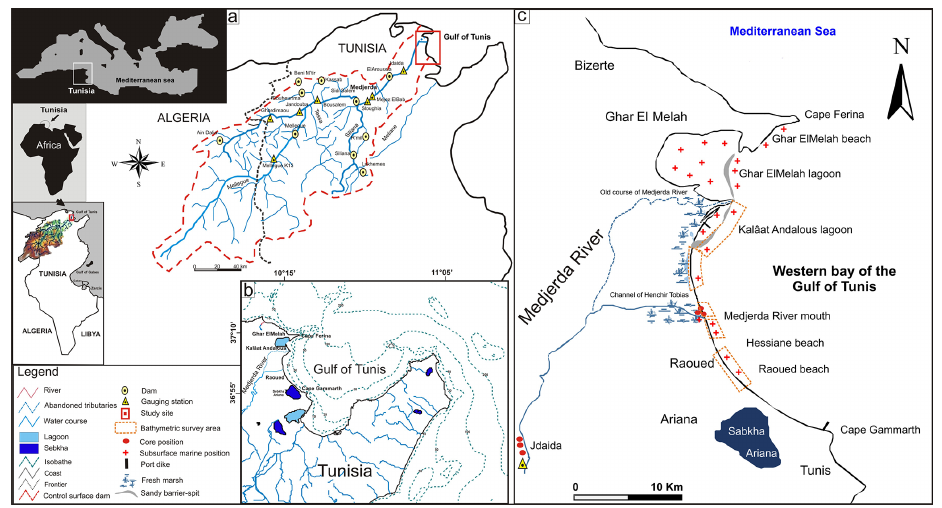
Figure 1. (a) Location map (from Kotti el al., 2018a) (b) Nearshore setting (c) Multi-criteria approaches methods in the Medjerda deltaic plain and coastal areas, Gulf of Tunis,